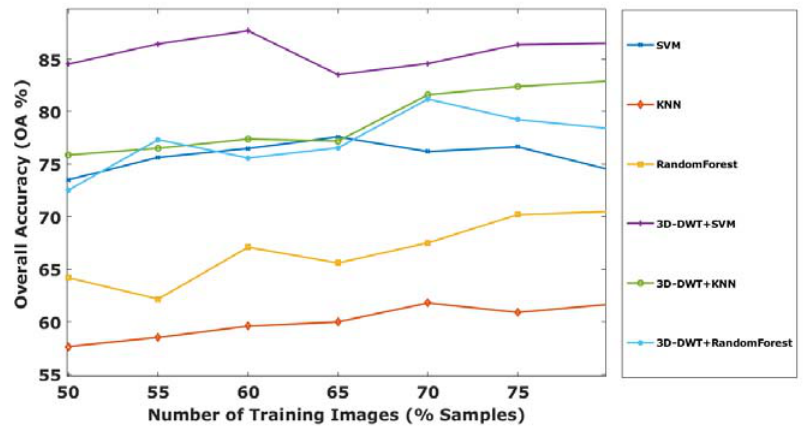
Figure 11. OA of all computing methods with a different percentage of Salinas Scene training samples.